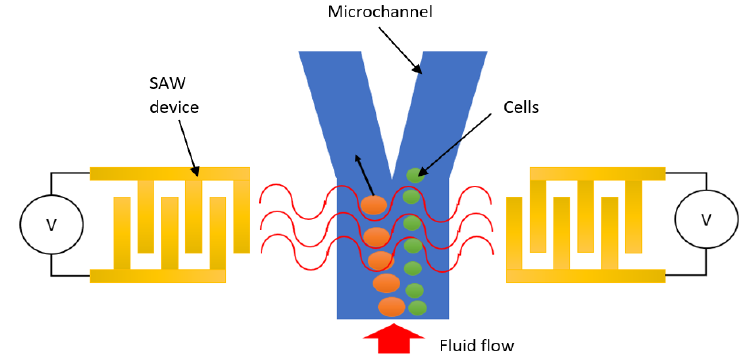
Figure 5. Illustration of cell separation using SAW